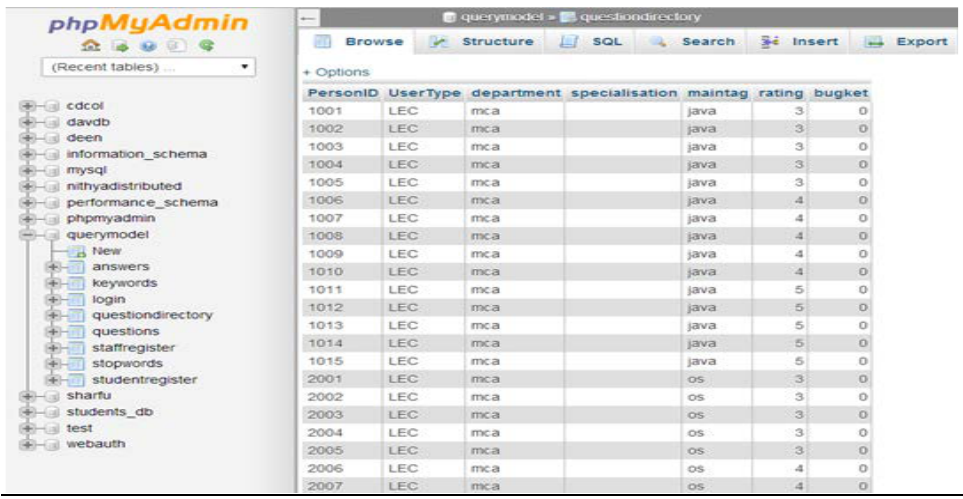
Figure 3. Expert domain directory